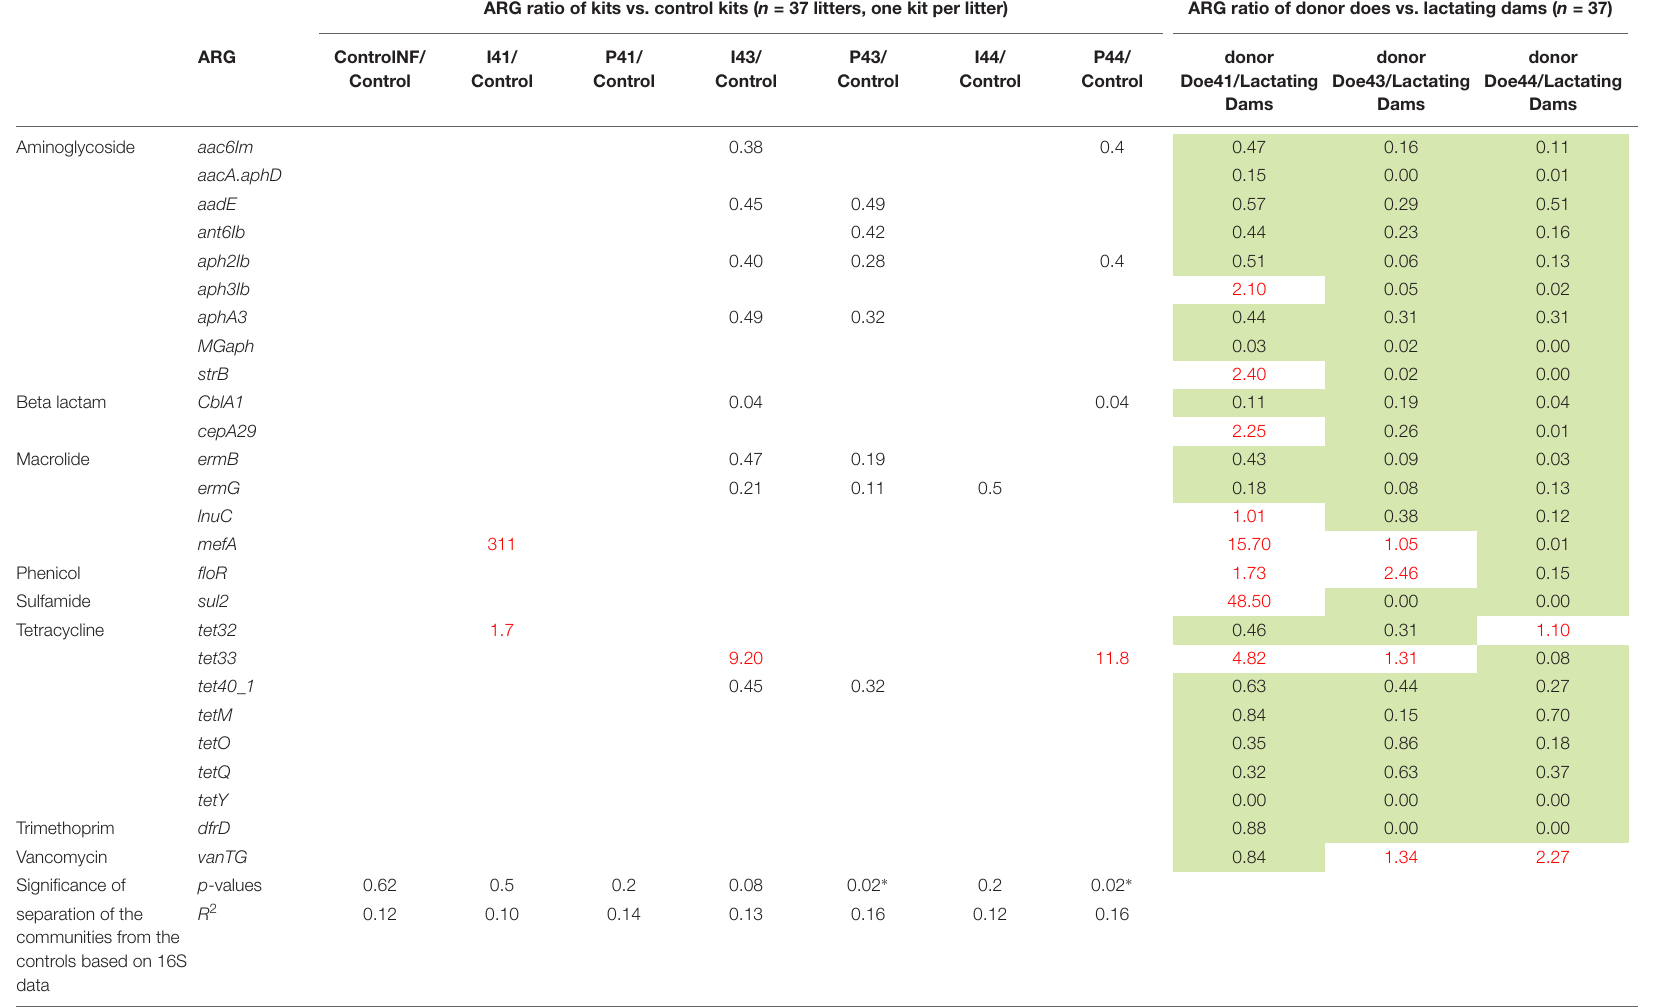
TABLE 1 | Ratios of relative ARGs abundances in kits and in the three donor